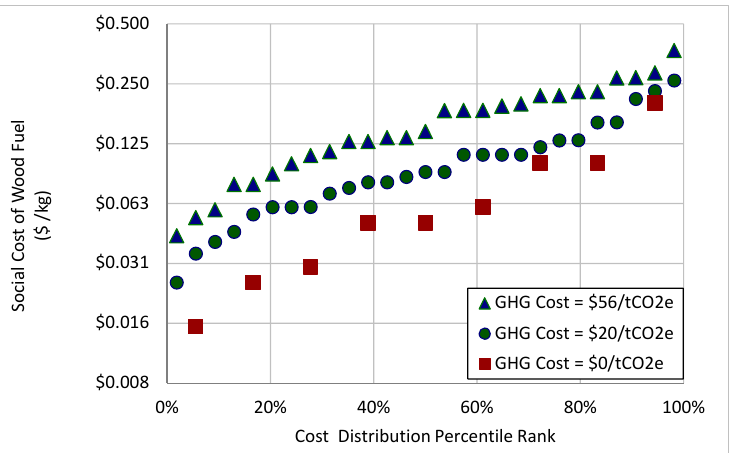
Figure 1. Distribution of opportunity and environmental costs of wood fuel based on cost input parameters provided in Table 1. The upper curve represents a social cost of carbon of USD 56/tCO 2 e, the middle curve represents a GHG cost of USD 20/tCO 2 e, and the lower points represent no environmental cost of wood use.